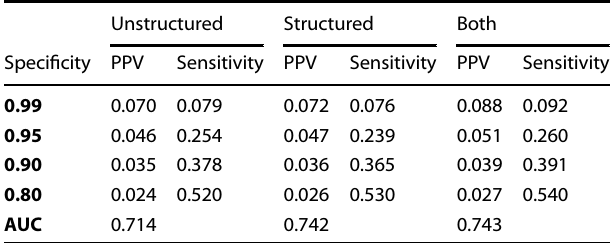
Table 2. Performance of NBC models on the test set.